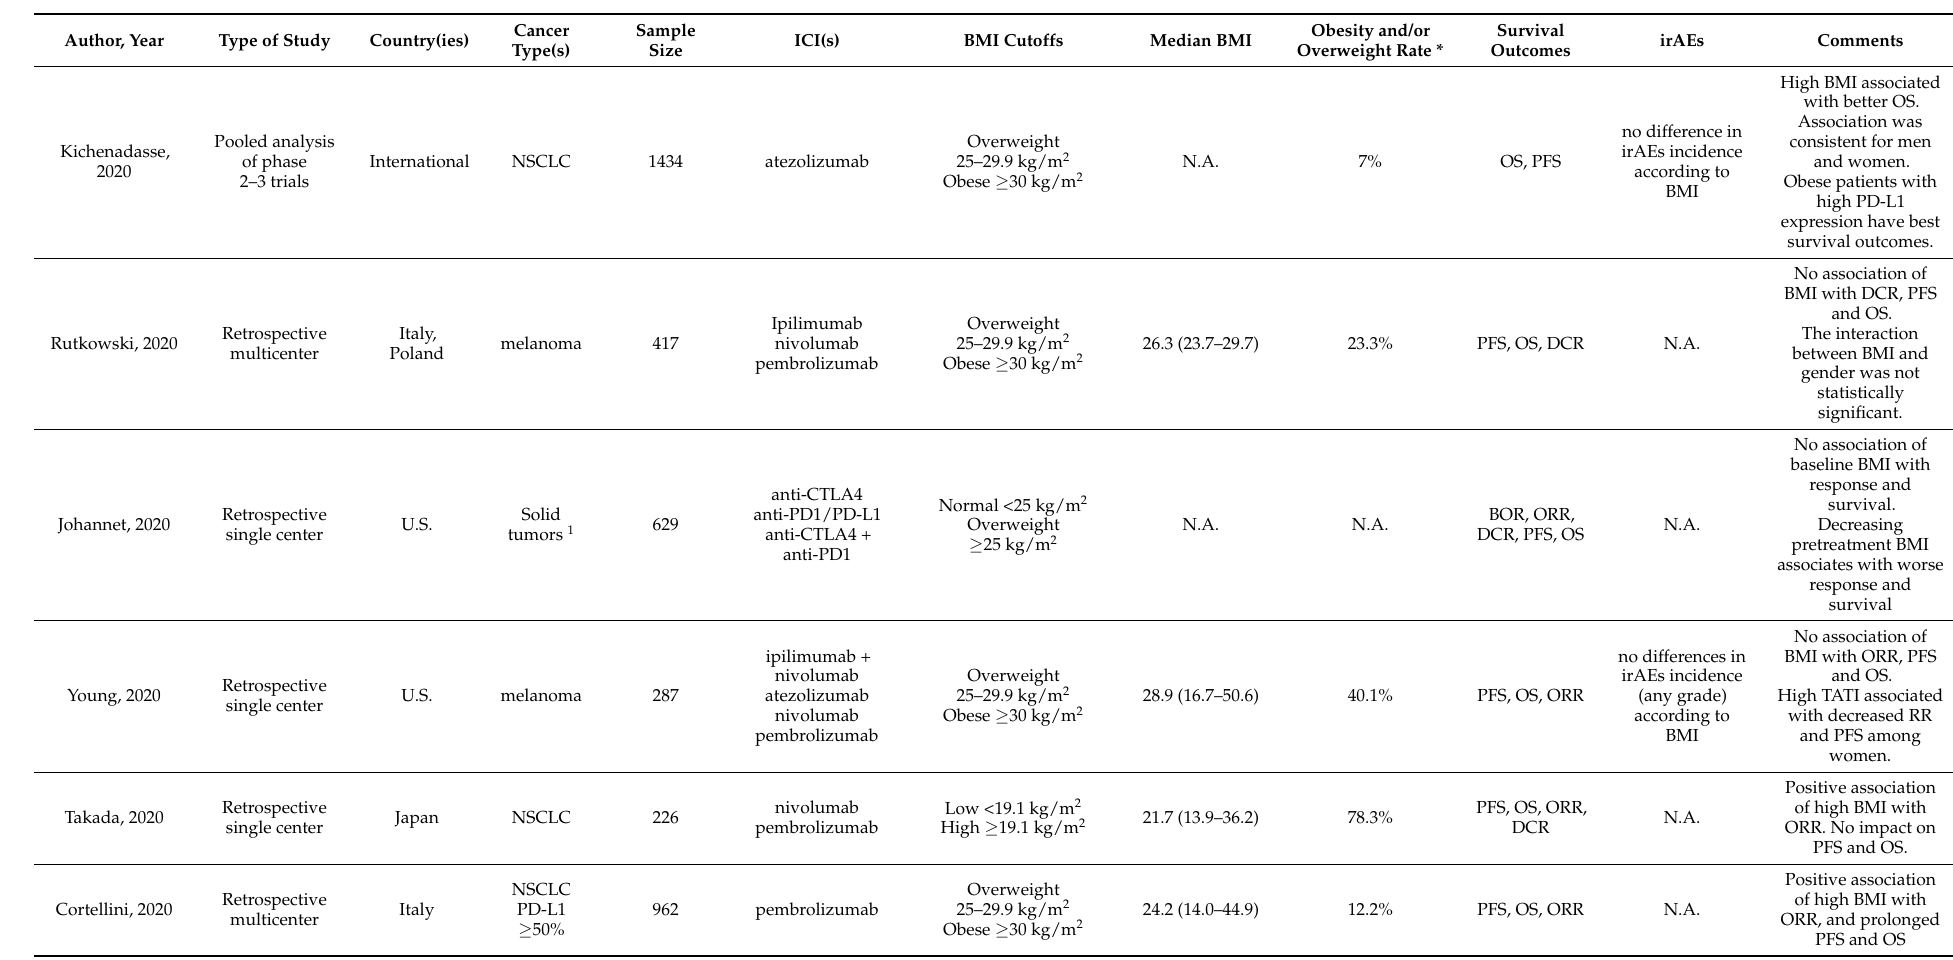
Table 1. Main characteristics of the included